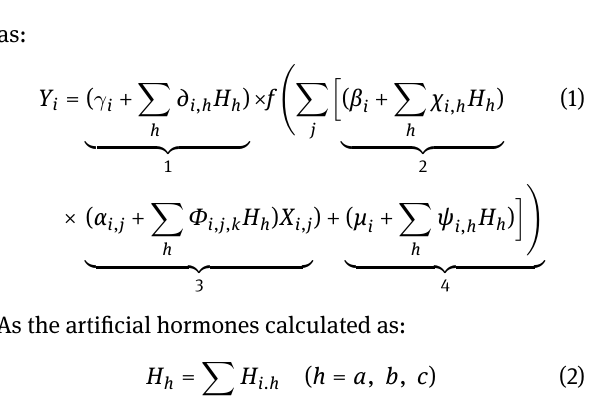
Figure 2: The three-layer FFNN model